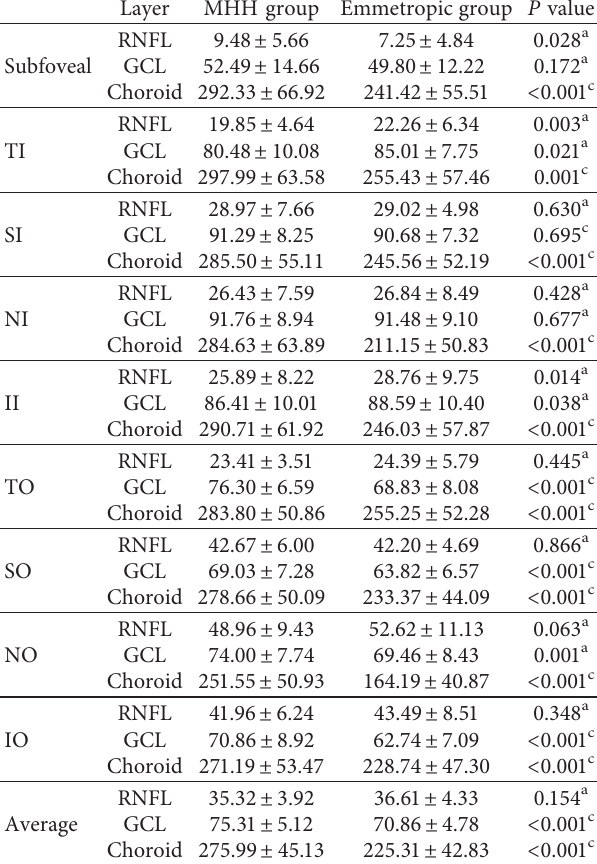
temporal sector of the inner ring; TO: temporal sector of the outer ring.